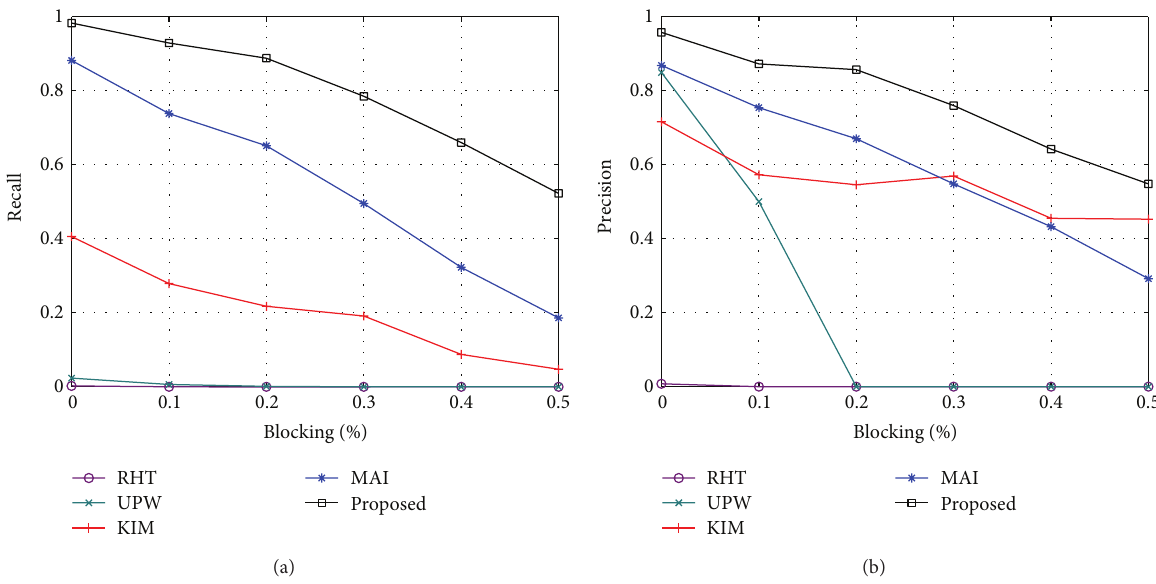
Figure 13: Recall and precision of each method for different ratios of occlusion (a) Recall. (b) Precision.